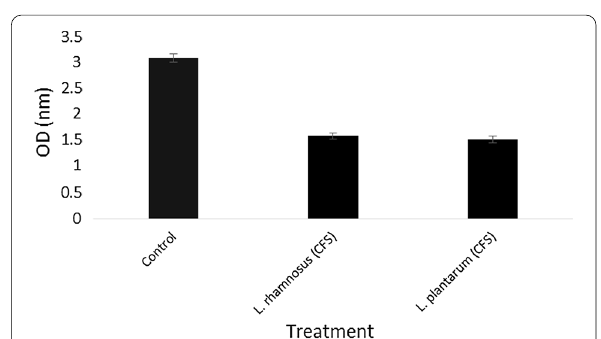
Fig. 3 Antagonistic activity of the cell-free supernatant on P. aeruginosa